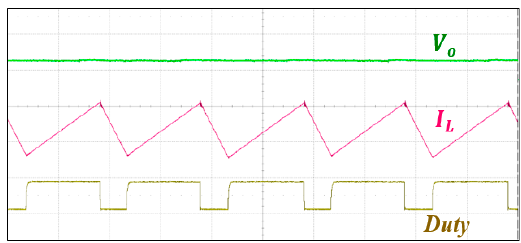
Figure 25. Inductor current waveform before a drop in output voltage. (10 V/div, 1 A/div, 25 us/div).